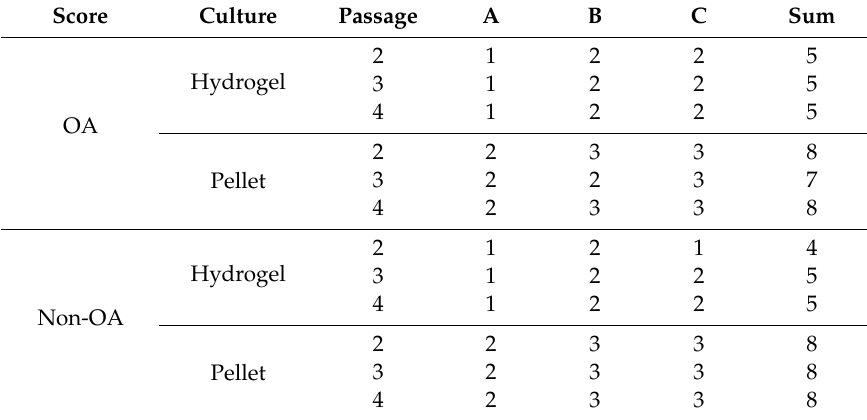
Figure 2. Safranin O/Fast Green staining of osteoarthritic (OA) human articular chondrocytes growing on a hydrogel ( A – C ) or in pellet culture ( D – F ). ( A + D ) Passage 2; ( B + E ) Passage 3; ( C + F ) Passage 4. Scale bars: 50 µm ( A – F ), 100 µm ( D – F , inserts). Table 1. Bern Score of each criterion (A = intensity of Safranin O staining, B = cell morphology, C = cell–cell distance).